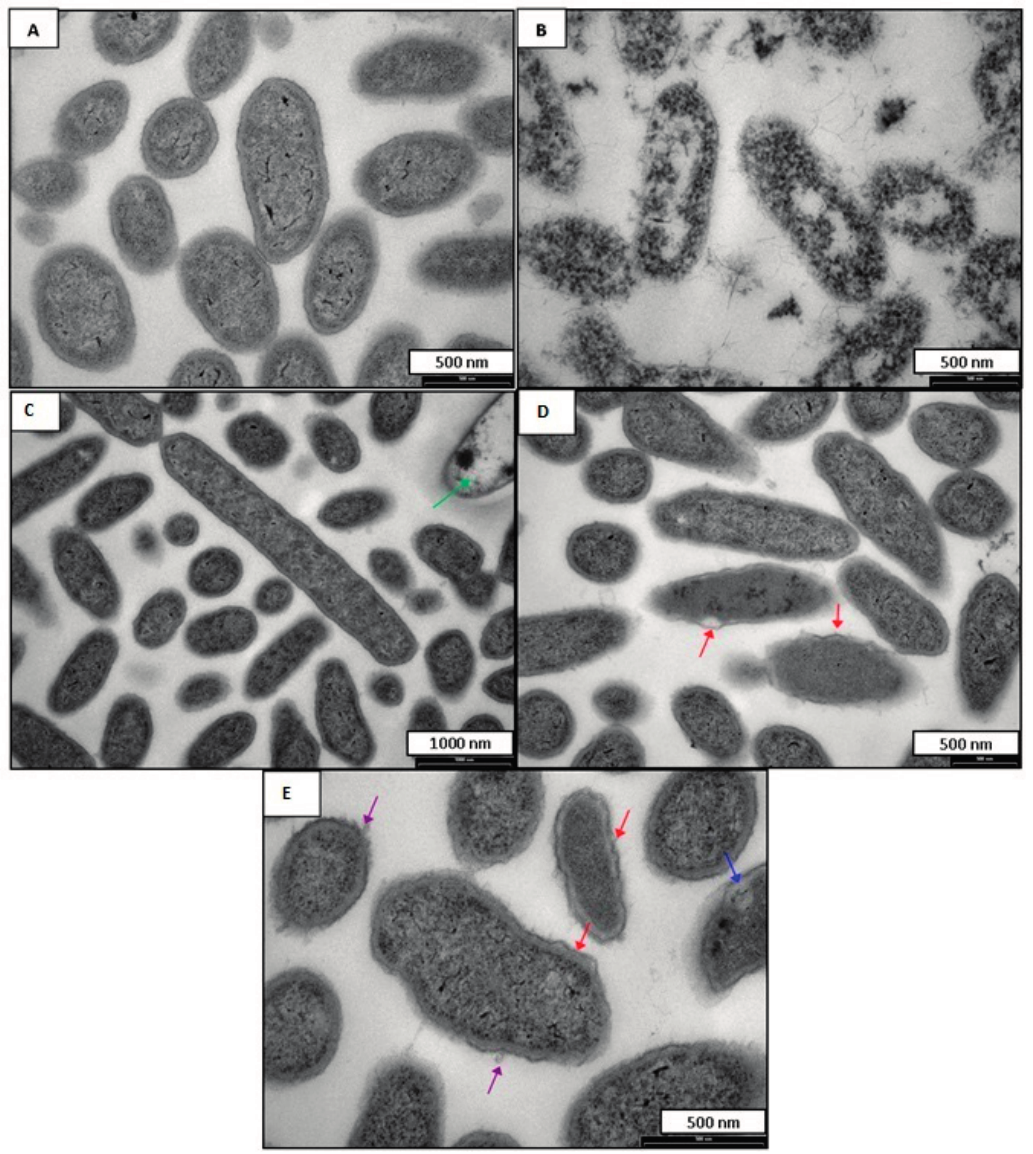
Figure 2. TEM images of B. fragilis ( A ) B. fragilis untreated; ( B ) B. fragilis treated with 0.02% Triton X-100; ( C – E ) B. fragilis treated with 20 mg·mL − 1 of CD-100. Red arrows indicate cell membrane rippling and separation of the cell wall from cytoplasmic contents. Purple arrows indicate blebbing. Green arrows indicate bacterial ghosts. Blue arrows indicate an area of reduced electron